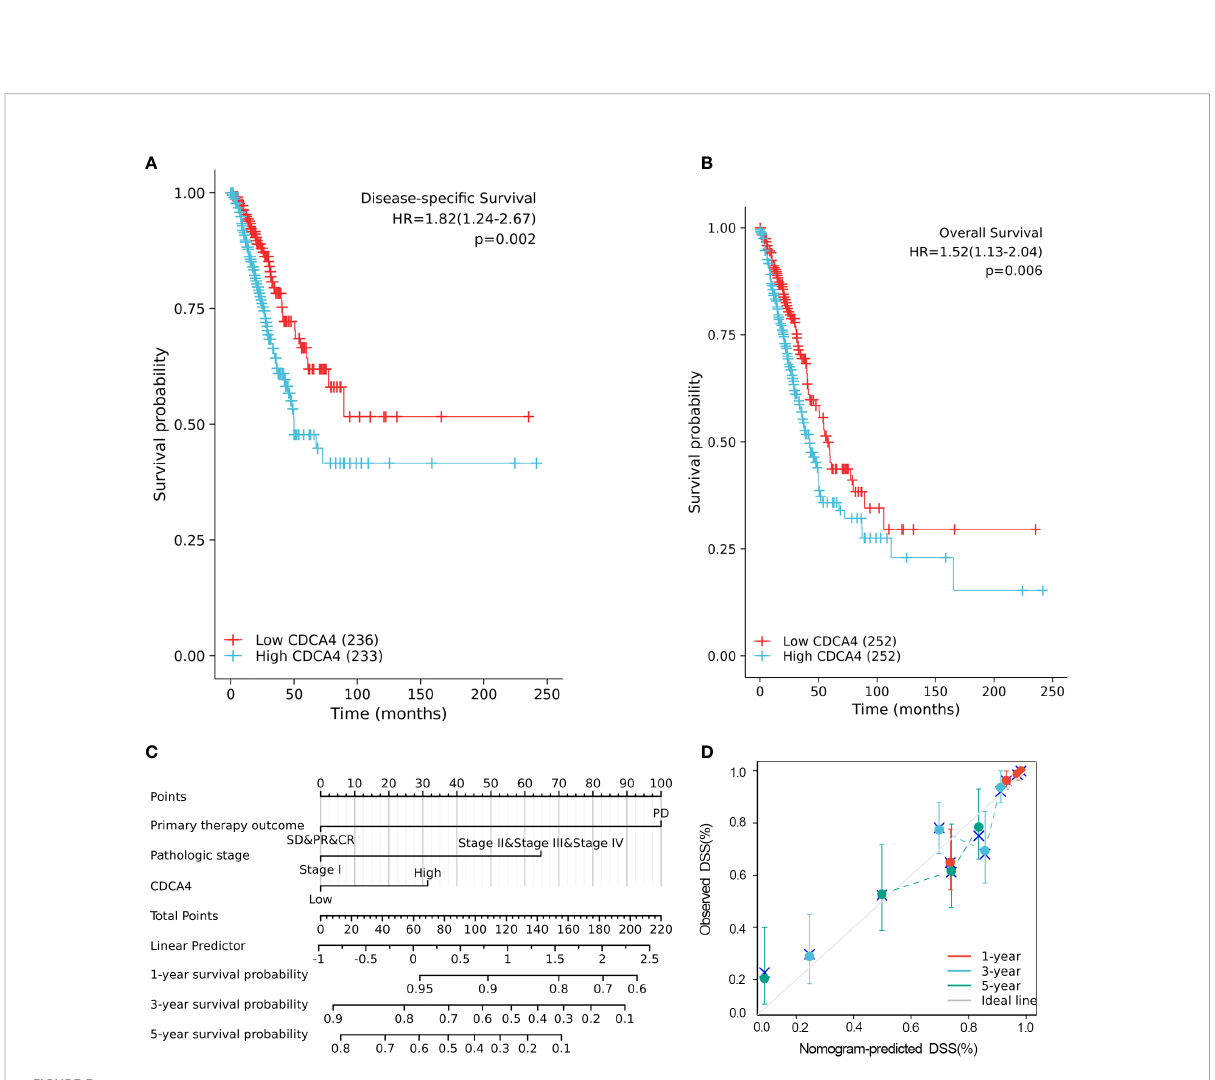
FIGURE 3 Higher CDCA4 expression was associated with poorer prognosis in LUAD. (A, B) KM survival analyses exhibited that patients with high CDCA4 levels had worse prognoses of DSS and OS (DSS HR=1.82,95% CI=1.24-2.67, P =0.002; OS HR=1.52; 95% CI=1.13-2.04, P =0.006). (C) Nomogram constructed using DSS related clinical factors and CDCA4. (D) Calibration plots showing good agreement with the best performance for DSS. DSS, disease-speci fi c